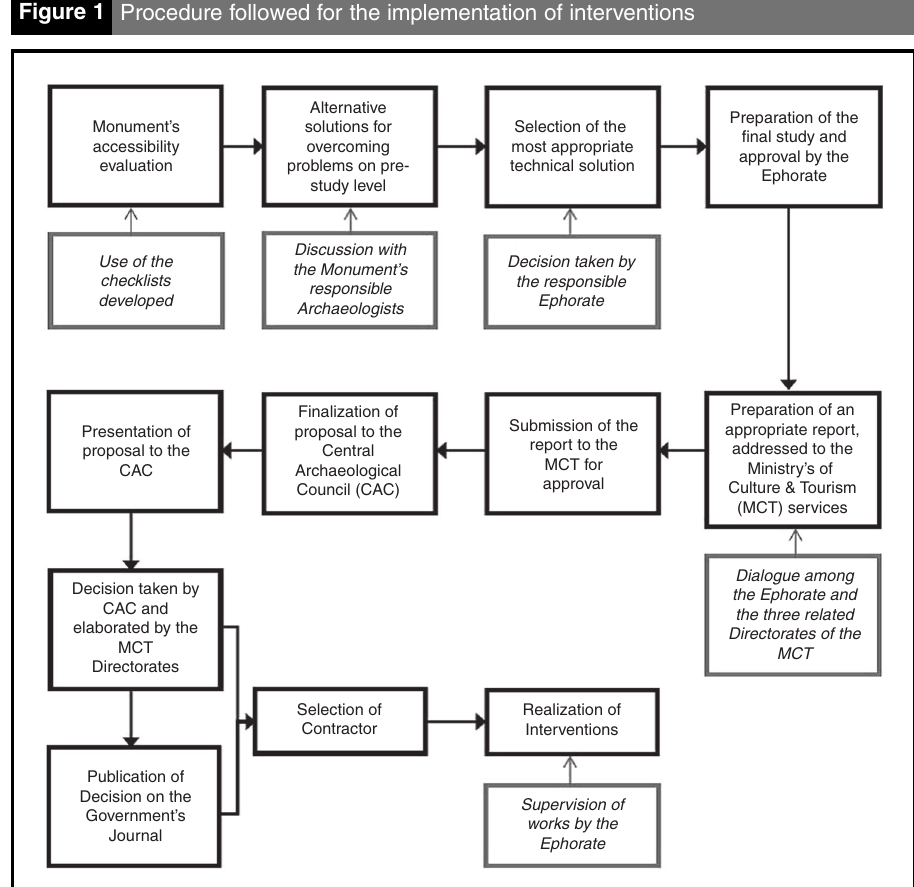
Figure 1 Procedure followed for the implementation of